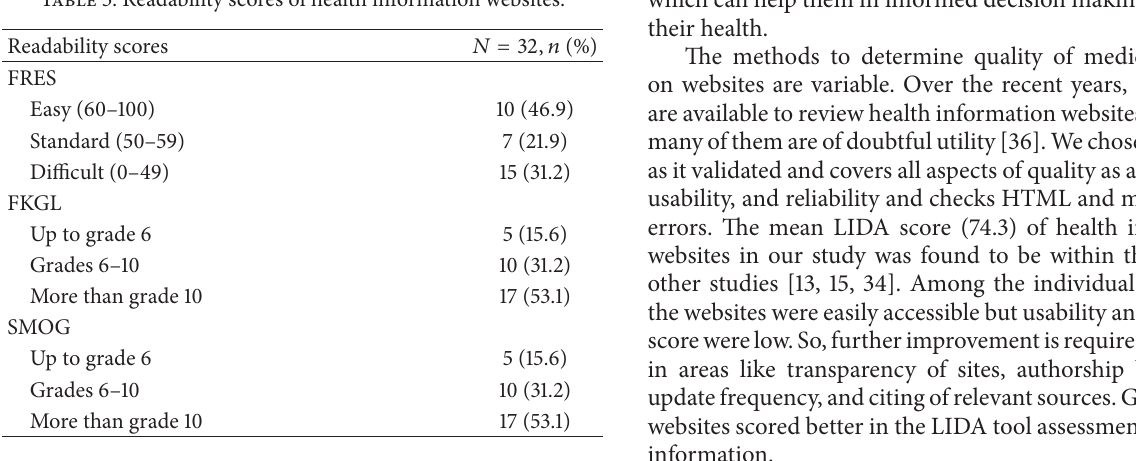
Table 3: Readability scores of health information